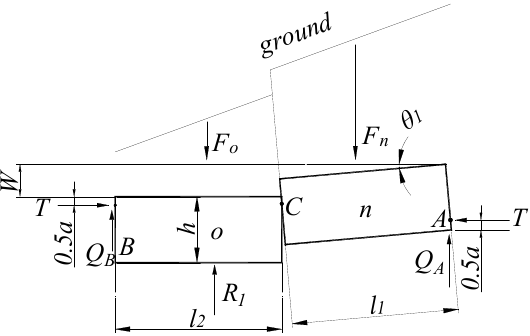
Figure 9. Structural force model of block of rock with periodic weighting of the main roof.